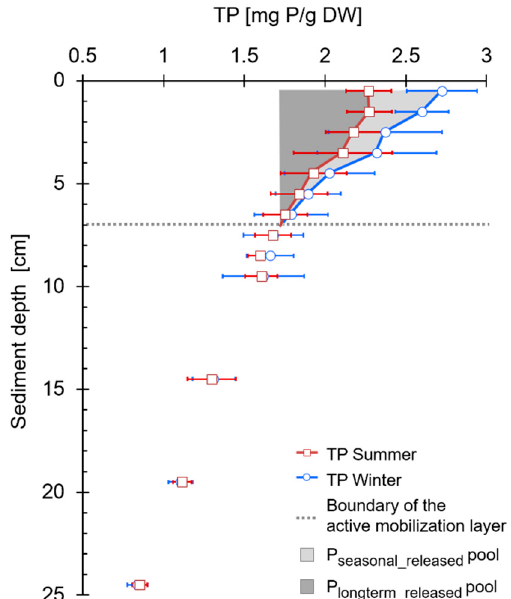
Figure 2. Total phosphorus (TP) content in the sediment in the summer (June 2017) and winter (April 2018). Data presented are mean concentrations of the sediment samples of the six cores collected in each season, the error bars shows the standard deviation. The two pools that make up the internal released P are highlighted in gray. For location of the sediment core sampling stations, see Figure 1.